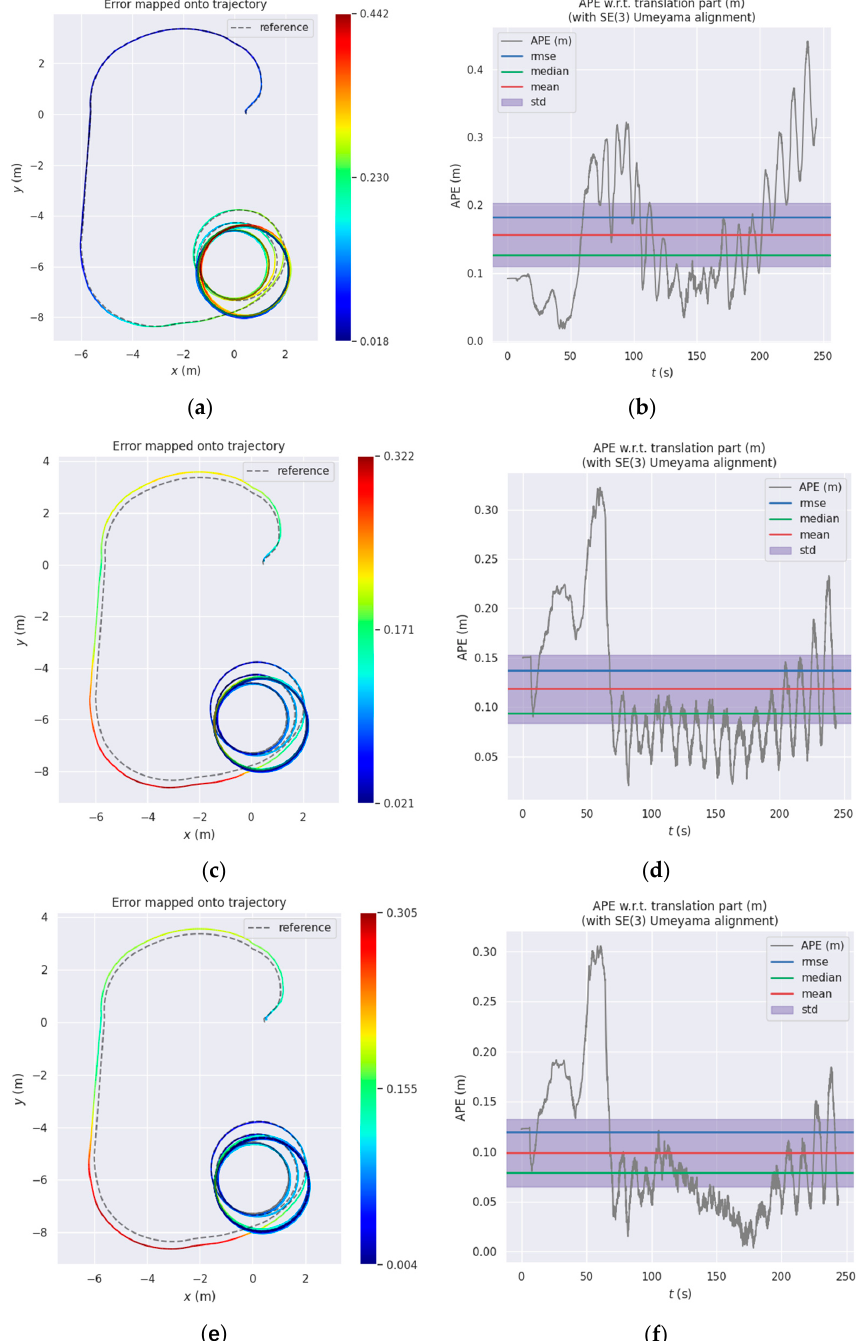
Figure 3. Comparison of the proposed method versus OpenVINS: ( a ) OpenVINS; ( c ) OpenVINS+IMU Pre-integration; ( e ) OpenVINS+IMU Pre-integration + Odom; ( b , d , f ) are the corresponding errors.